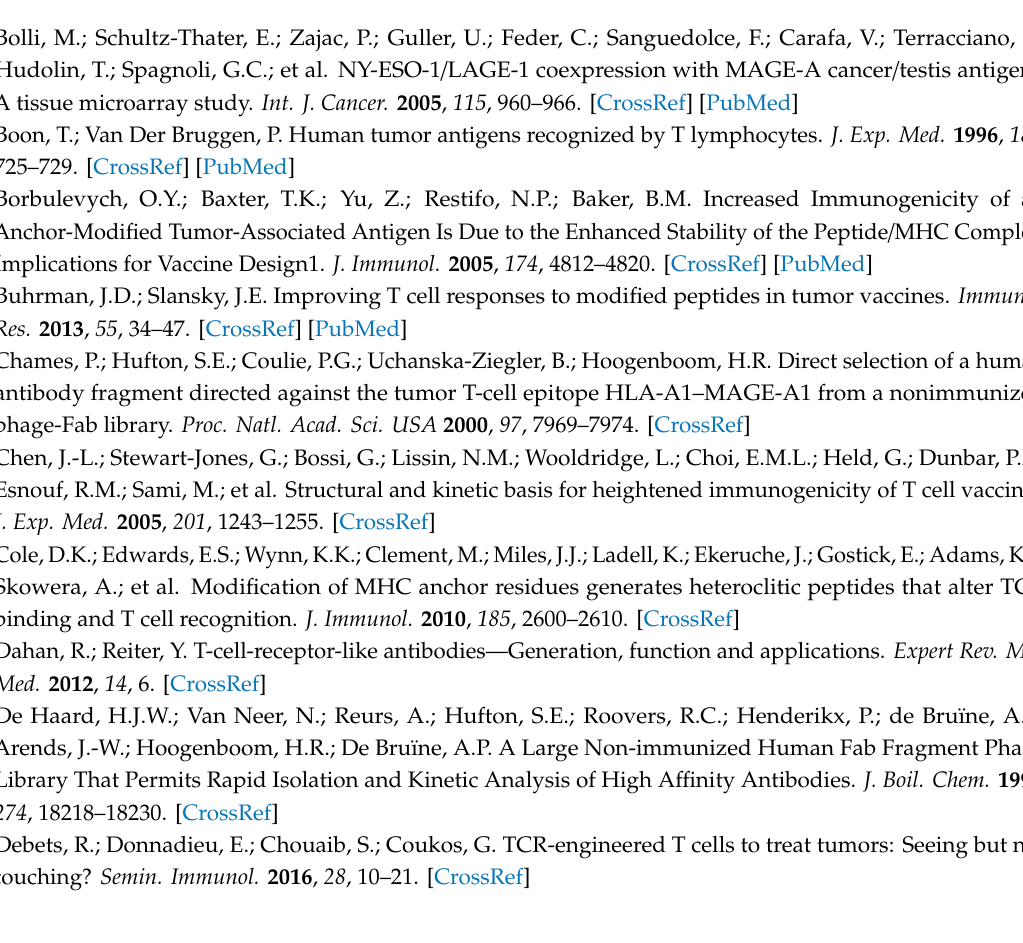
Figure S1: Complete PCR Gel showing the expression of MAGE A3 on tumor cell lines, Figure S2: Complete PCR Gel showing the expression of MAGE A6 and MAGE A10 on tumor cell lines, Figure S3: Complete PCR Gel showing the expression of MAGE A6, MAGE A10 and MAGE A12 on tumor cell lines, Figure S4: Complete PCR Gel showing the expression of MAGE A1, HLA A1, HLA A2 and GAPDH on tumor cell lines, Table S1: Sizes and compositions of the phage-Fab libraries, Table S2: Validation of phage-Fab library following selections with a set of control proteins, Table S3: Sequences of control proteins used for validation of phage-Fab